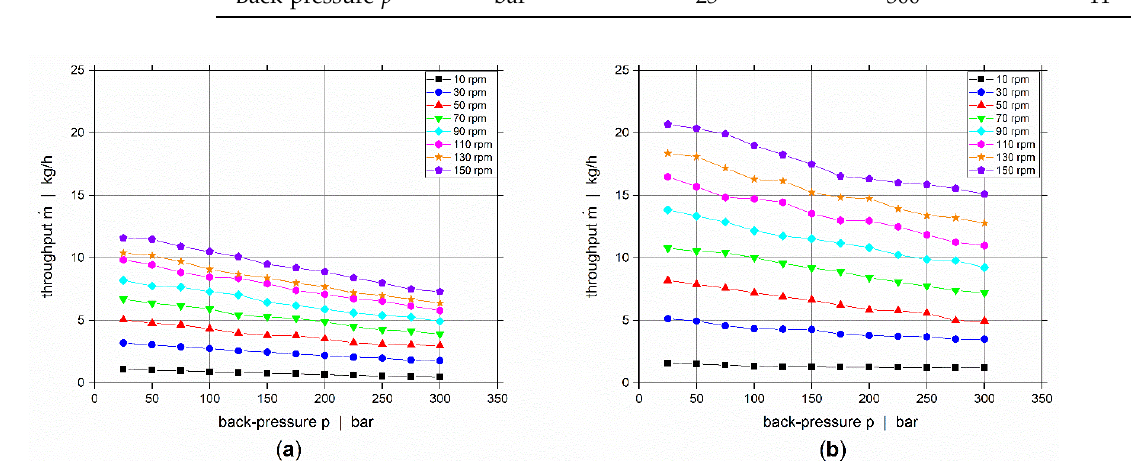
Figure 4. Screw characteristic curves for ( a ) polymer, and ( b ) compound.